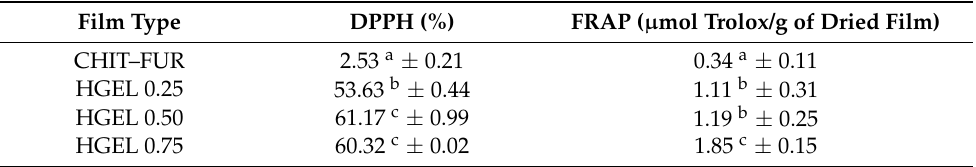
Antioxidant activity of CHIT–FUR and CHIT–FUR/HGEL films with RE in different concentrations. Film Type DPPH